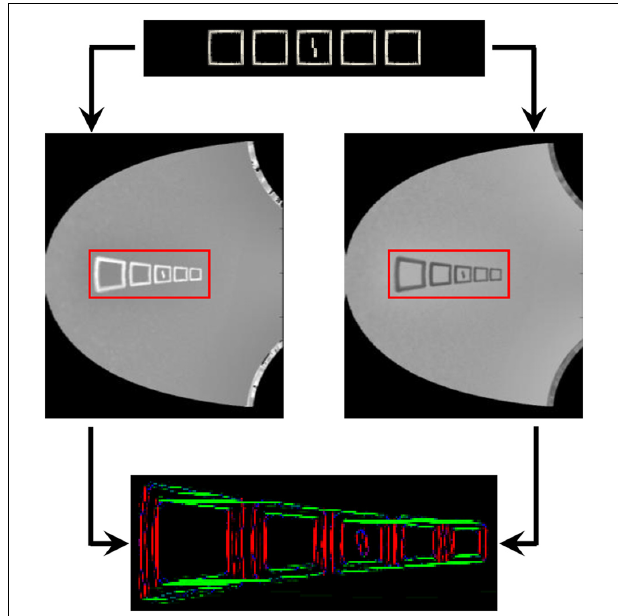
FIGURE 15 | Formation of illusory contours in the full visual system for the 5-square-flankers condition of Figure 4A . The image on the top is the visual input to the visual system, both images in the middle are the output of the ON-centered (left) and OFF-centered (right) ganglion cells of the retina model (only the right visual field), and the image on the bottom is the output of the segmentation model. Illusory contours are formed between almost all squares, but they sometimes come from the alignment of the very top of one square with the inner part of the top of the other